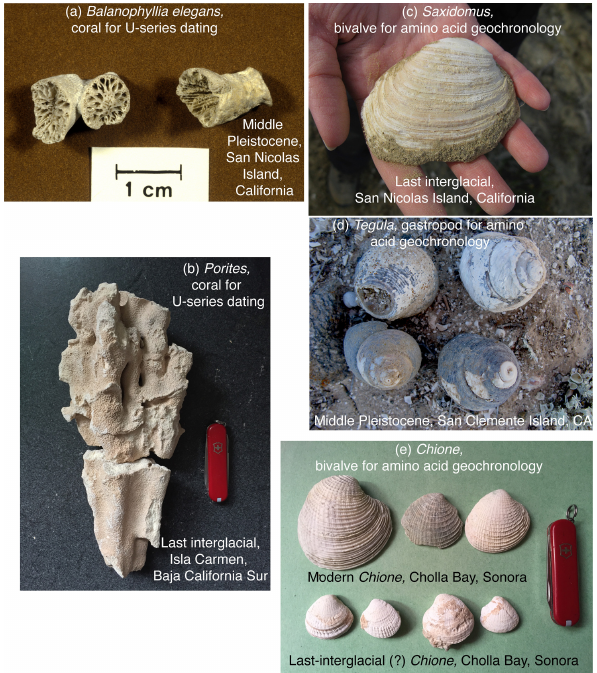
Figure 8. Examples of fossil marine organisms used for geochronology of marine terrace deposits on the Pacific coast of North America: (a) solitary corals Balanophyllia elegans (fossil), San Nicolas Island, California (U-series dating); (b) Porites pana- mensis (fossil), Isla Carmen, Baja California Sur (U-series dat- ing); (c) Saxidomus (fossil), San Nicolas Island, California (amino acid geochronology); (d) Tegula (fossil), San Clemente Island, Cal- ifornia (amino acid geochronology); (e) Chione (modern: upper row; fossil: lower row), Cholla Bay, Sonora, Mexico (amino acid geochronology). All photographs by Daniel R.